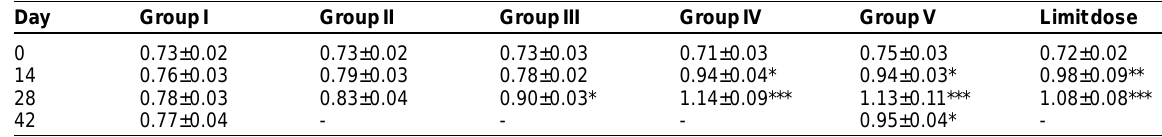
Table-4. Levels of serum creatinine (mg/dl) in rats fed with S. laurifolius leaf extract in repeated dose 28 day oral toxicity